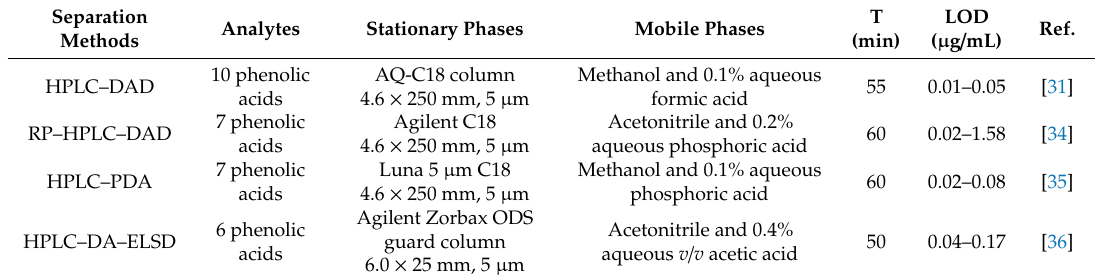
Table 1. Overview of the mentioned analysis methods of Lonicera japonica